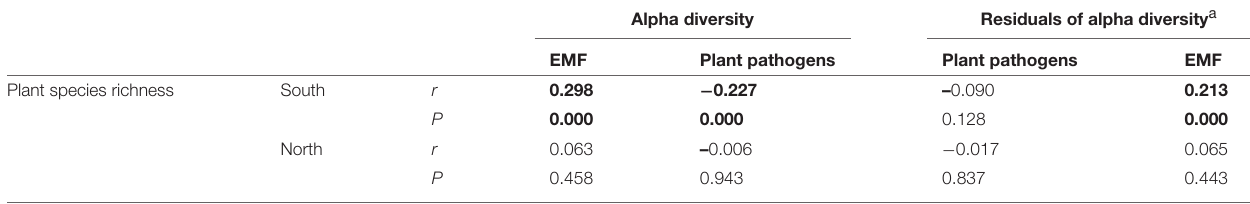
TABLE 1 | Pearson correlations between plant species richness and the alpha diversities of plant pathogens and ectomycorrhizal fungi (EMF).